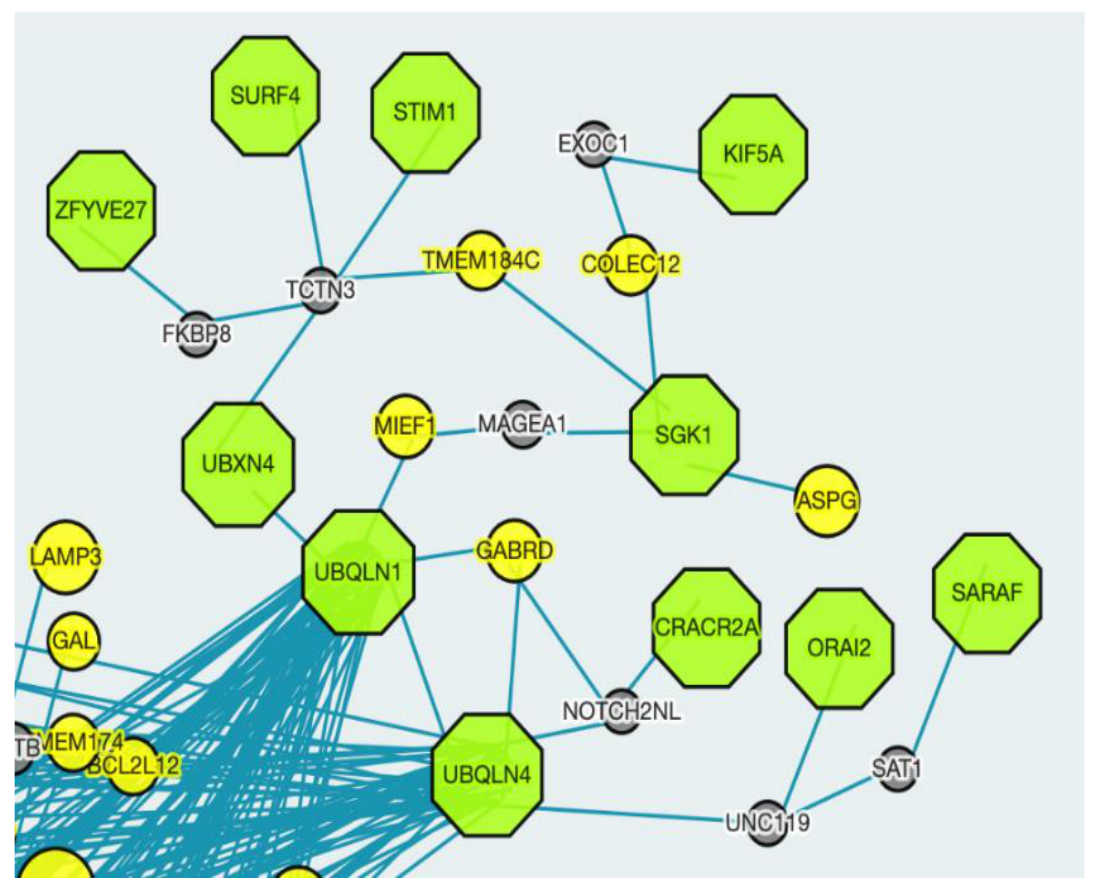
Figure 5. Subnetwork of genes associated with SOCE and connected to SURF4 .